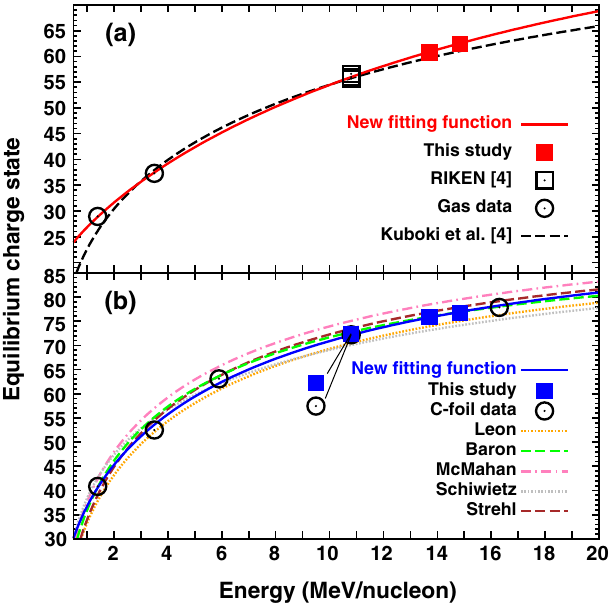
FIG. 7. Data of the equilibrium charge state of uranium ions in , Ar, and CO gases [4,19,20] and (b) C-foil [1,19–22] in (a) N 2 2 the energy range of 1 – 20 MeV = nucleon . (a) Solid squares rep- resent the data obtained in this study. Open squares represent the results of previous measurements [4]. Open circles represent the data for gases [19,20]. The equilibrium charge states in gases, as predicted by the new fitting function q gas eq ¼ Z ½ 1 (cid:2) Þ 1 : 63 Z (cid:2) 1 : 17 g(cid:6) are represented by the solid 0 : 784 exp f(cid:2)ð v=v 0 curve. The dashed curve represents the charge states predicted using the empirical formula [4]. (b) The data obtained in this study is represented by solid squares. Open circles represent the data available for C-foil [1,19–22]. The data at 11 MeV = nucleon obtained in this study is in good agreement with previous data [1]. The blue, orange, green, magenta, gray, and brown curves represent the charge states for solid materials, as predicted by the ¼ Z ½ 1 (cid:2) empirical formulas proposed by us, i.e., q C - foil eq Þ 1 : 20 Z (cid:2) 0 : 736 g(cid:6) , Leon et al. [24], Baron et al. 0 : 835 exp f(cid:2)ð v=v 0 [5], McMahan et al. [25,26], Schiwietz et al. [27], and Strehl [28],